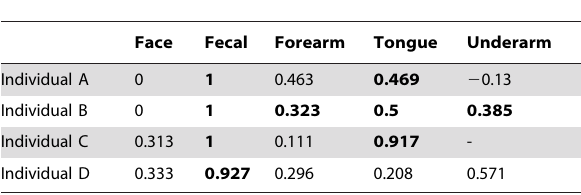
Table 3. Results of ANOSIM tests comparing the affect of extraction method on bacterial community structure (Bray- Curtis) of each body habitat from each individual.